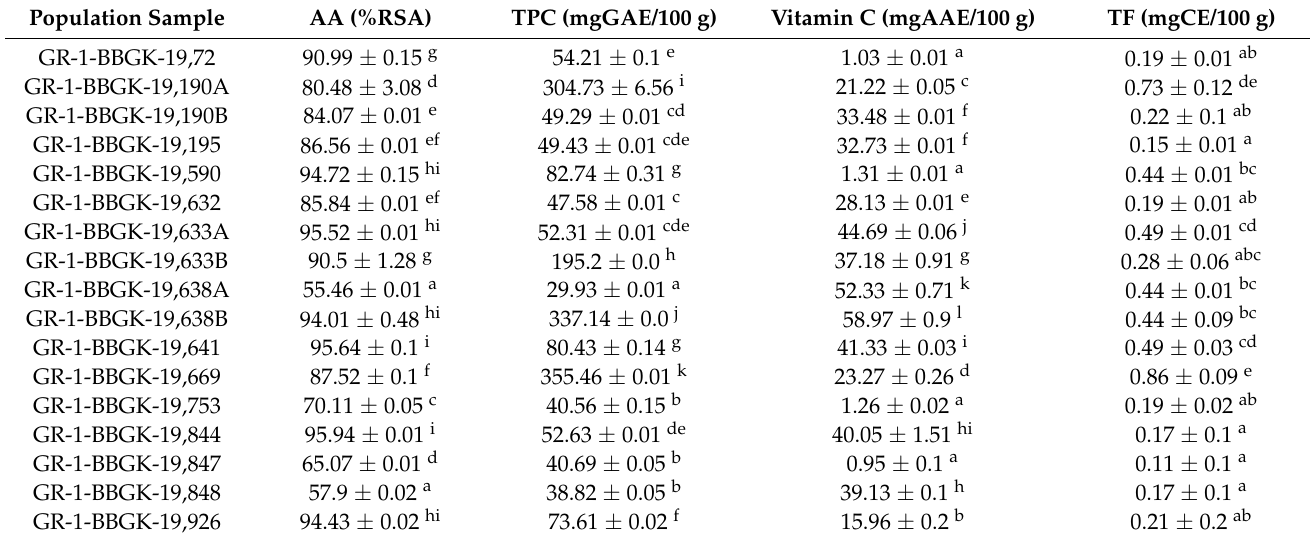
Values represent mean values ± standard deviation (S.D.) of samples analyzed in triplicate ( n = 3); values within the same column that do not share the same letter are significantly different (Tukey post-hoc test, p < 0.05). For